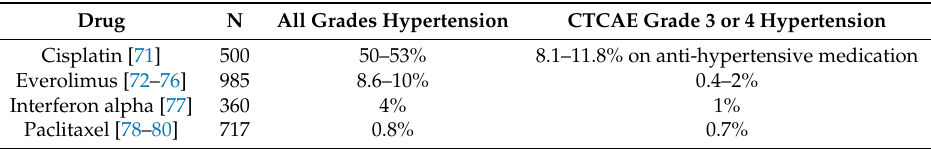
Table 3. Legacy and conventional chemotherapy and hypertensive